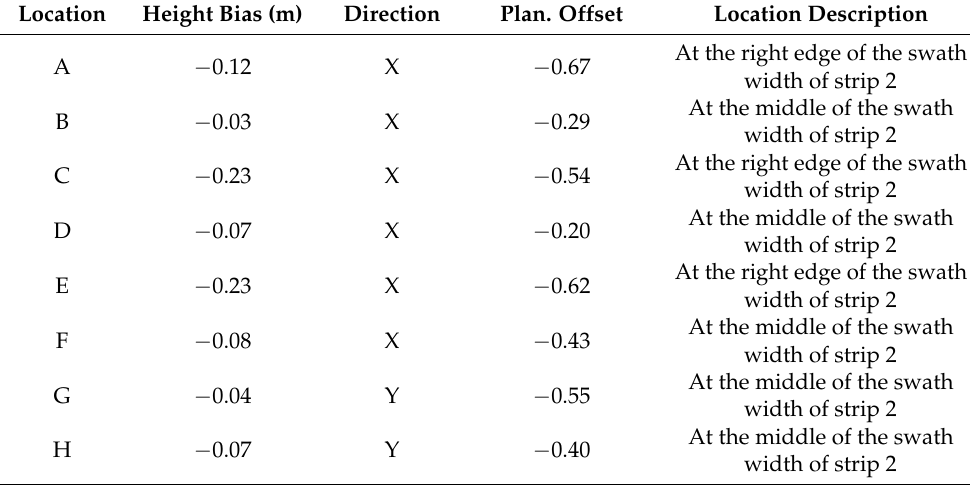
Table 2. Planimetric accuracy